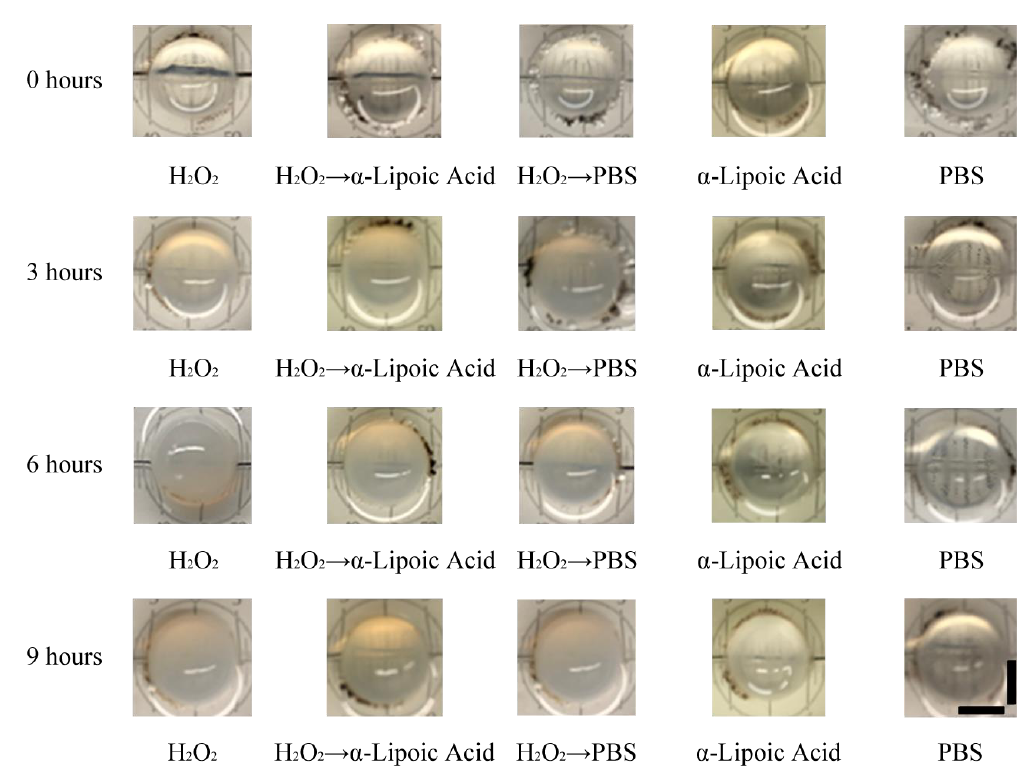
Photonics 2021 , 8 , x FOR PEER REVIEW 6 of 12 Figure 2. Photos of the lenses as a function of time and incubation media. The lenses at ( top row ) 0 h, ( second row ) 3 h, ( third row ) 6 h, and ( fourth row ) 9 h incubation time in the noted media. The scale bar is 5 mm.